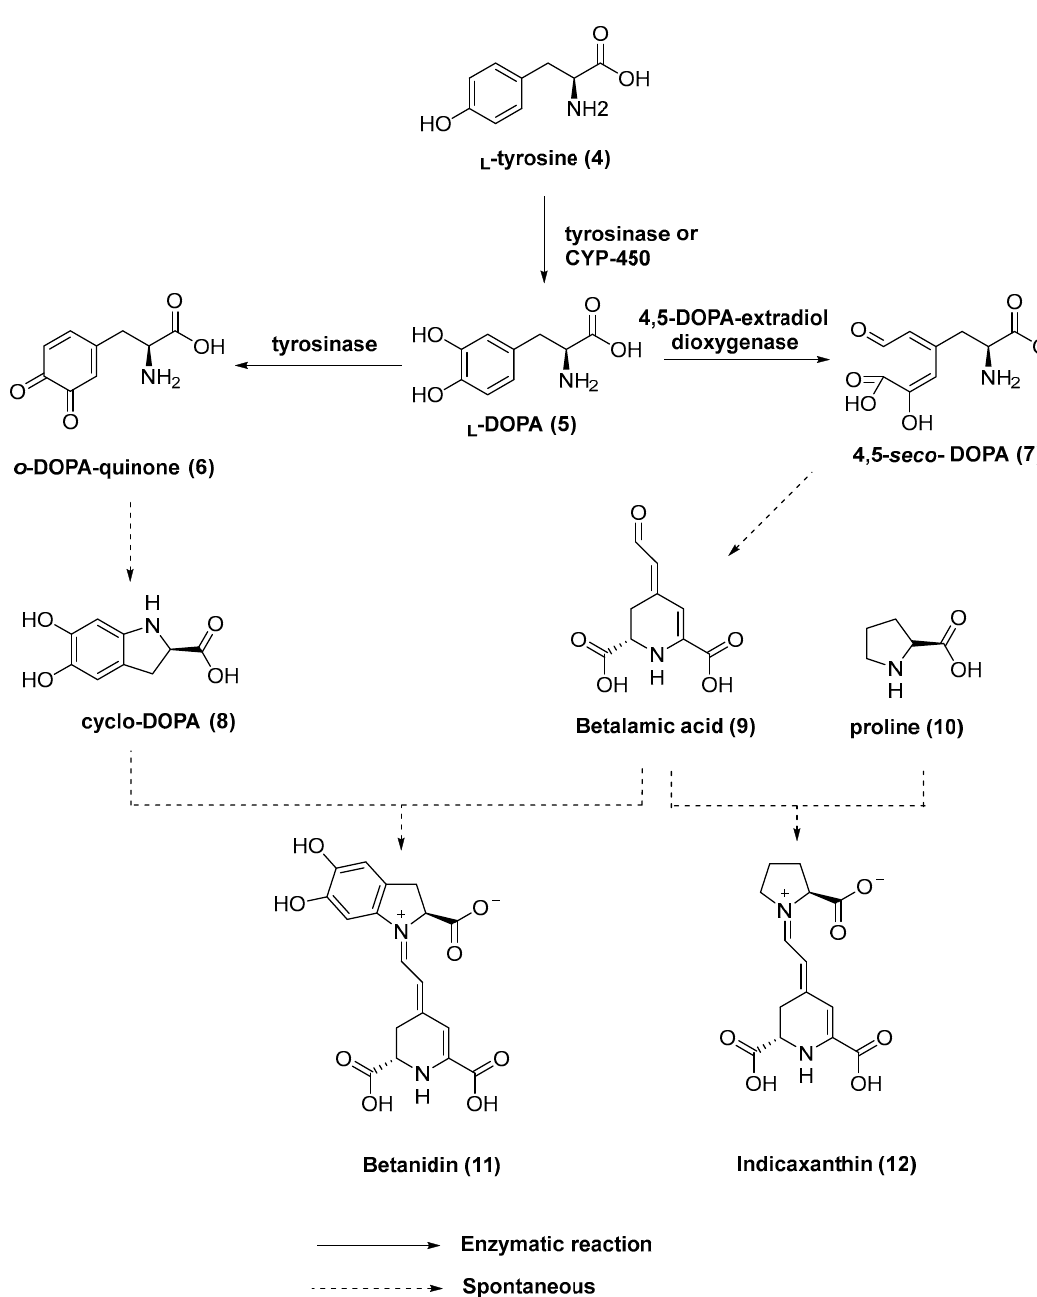
Figure 2. Biosynthetic pathway of betalains 11 and 12 .